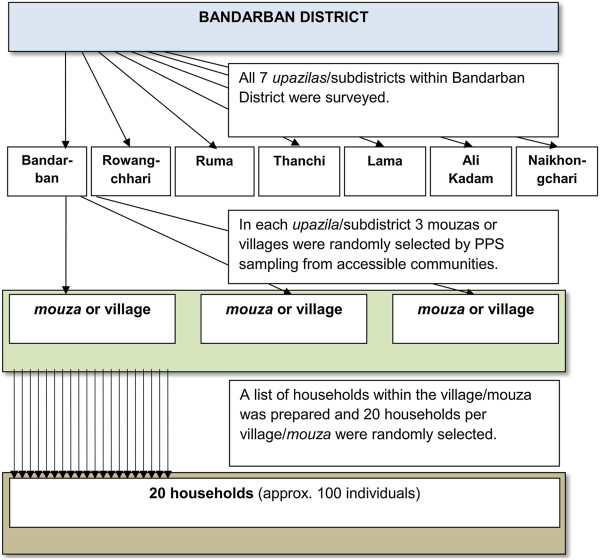
Flow chart for selecting clusters and households within Bandarban District. *PPS (probability proportional to size).